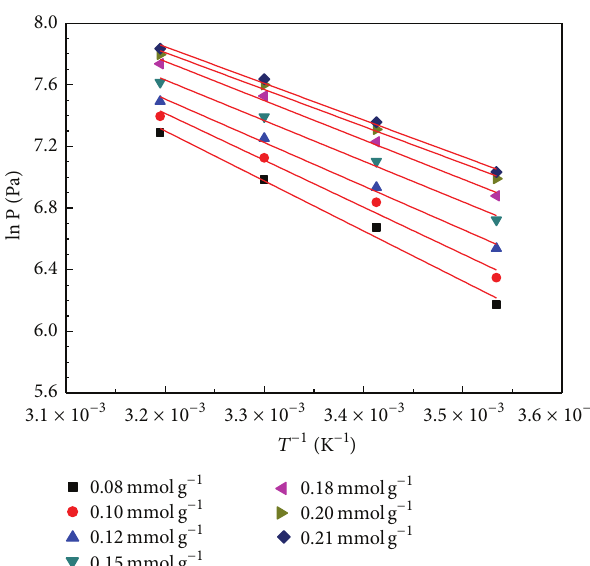
Figure 8: Temperature dependence of ln 𝑃 for water vapor adsorp- tion on the MFS-02.